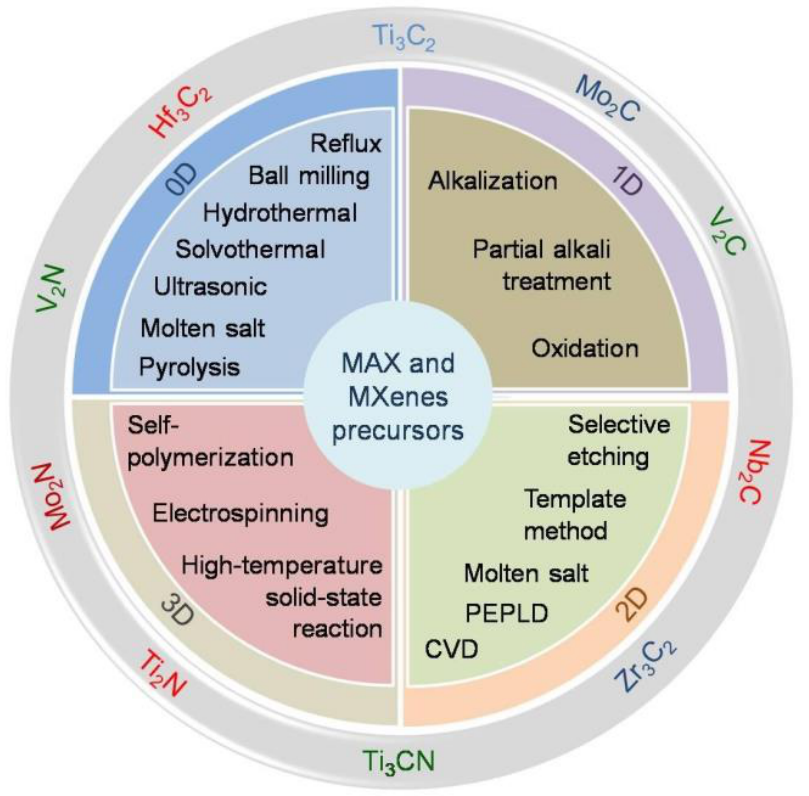
Figure 3. Compilation of recent fabrication methods of MXenes and derivatives depends upon their 0D, 1D, 2D, and 3D forms.